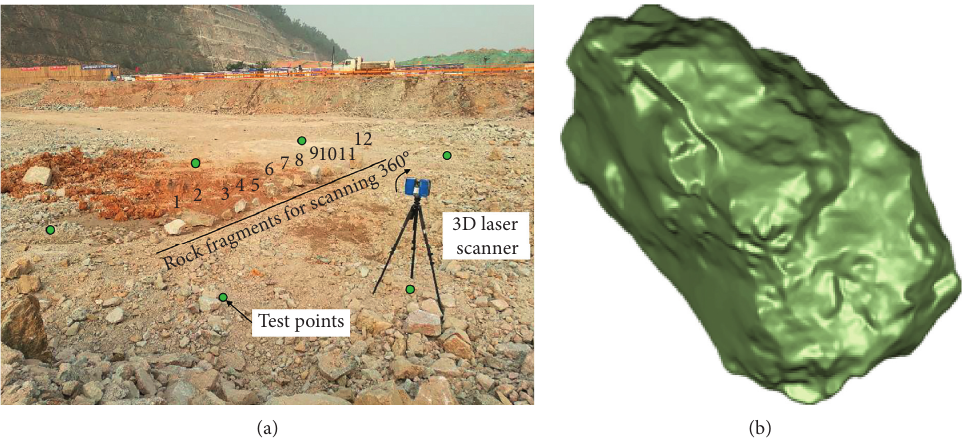
Figure 8: 3D laser scanning for large rock fragments. (a) Arrangement of scanning points. (b) 3D model of rock fragments.